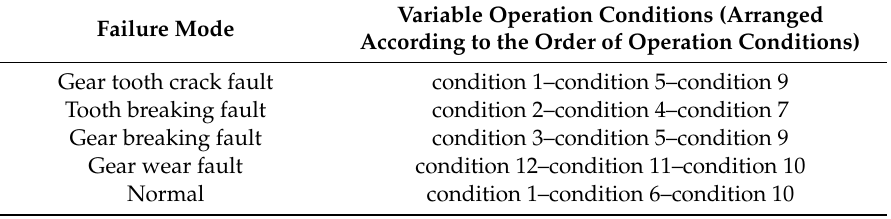
Table 3. Multi-operation condition